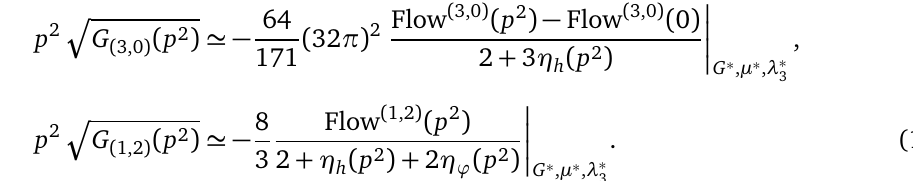
( k 2 ) exceed two, h